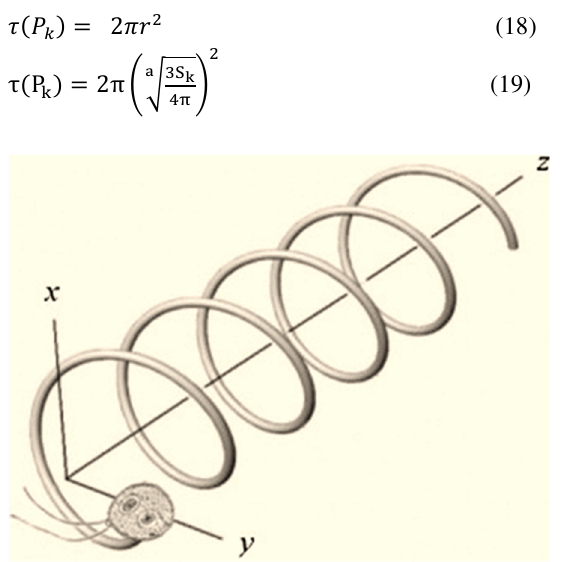
FIG. 2: HELICAL MOVEMENT OF MICROALGAE [30]